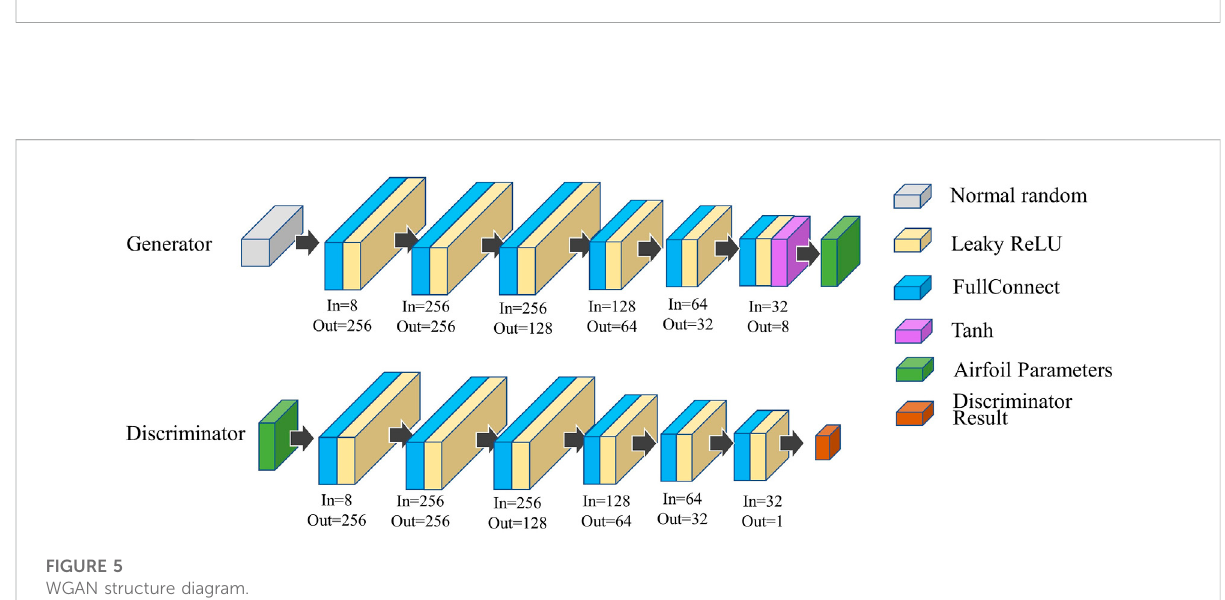
FIGURE 4 CNN and ResNet structure (when two blocks with the same output channel overlap, Only mark once, such as c = 64. When two blocks with differentoutputchannelsoverlap,markinorder,suchasc=64,48meansthattheoutputchannelofthepreviousblockis64,andtheoutputchannel of the next block is